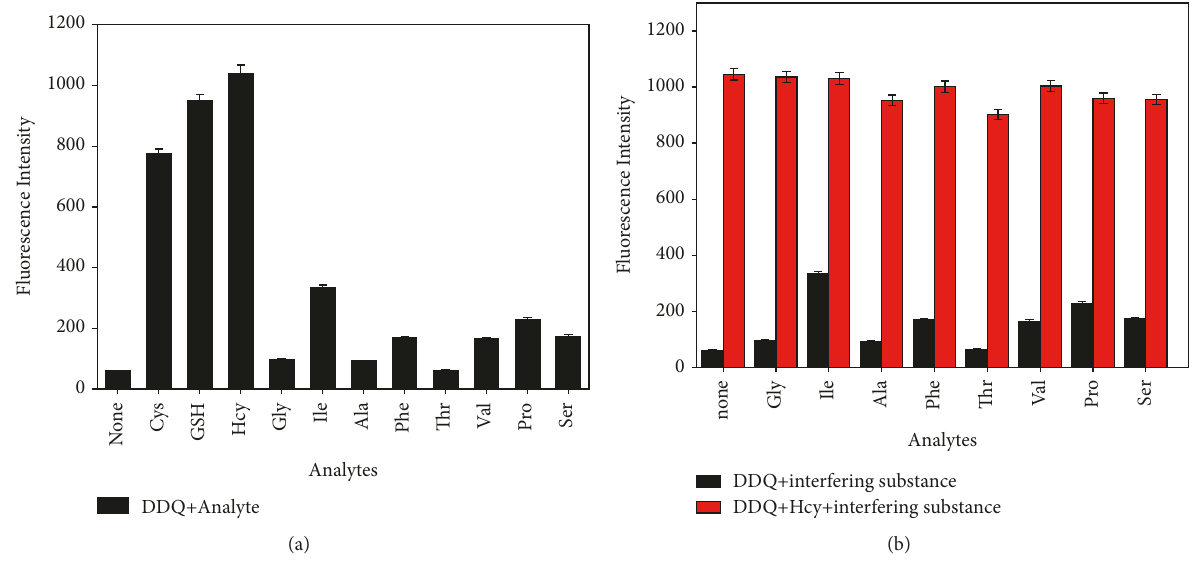
Figure 3: Fluorescence responses of DDQ to different substances. (a) Fluorescence responses of DDQ (10 𝜇 M) to different amino acids (Cys is 0.2 mM, Hcy is 0.1mM, and GSH and nonthiol-containing amino acids are 1mM). (b) The black and red histogram represent the fluorescence intensity of DDQ (10 𝜇 M) in the presence of various alalytes (1mM) before and after addition of Hcy (0.1 mM). Table 1: Comparison of DDQ to other fluorescent probes for biothiols